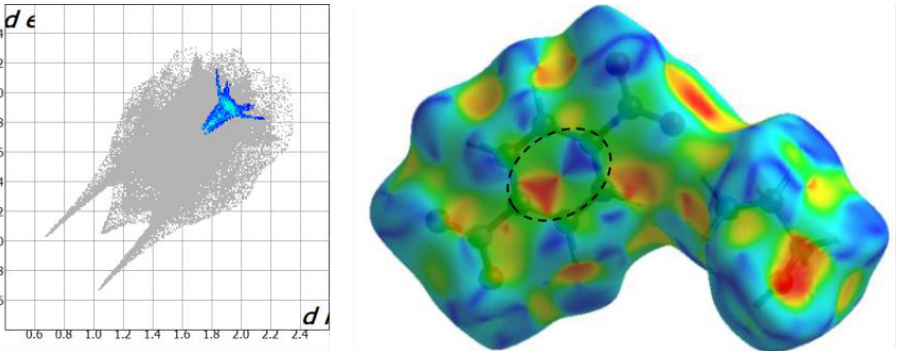
Figure 4. The 2D fingerprint plot ( left ) and shape index ( right ), ranging from −0.989 (red) to 0.996 (blue) Å, of the C ··· C interactions in HEA- p NBA. The relative contributions of the intermolecular contacts exhibited by both organic salts are depicted in Figure 5 which clearly shows that the other interactions are minimal in HEA- p ABA (only 3.5% representing N ··· H/H ··· N contacts) compared to 8.9% in